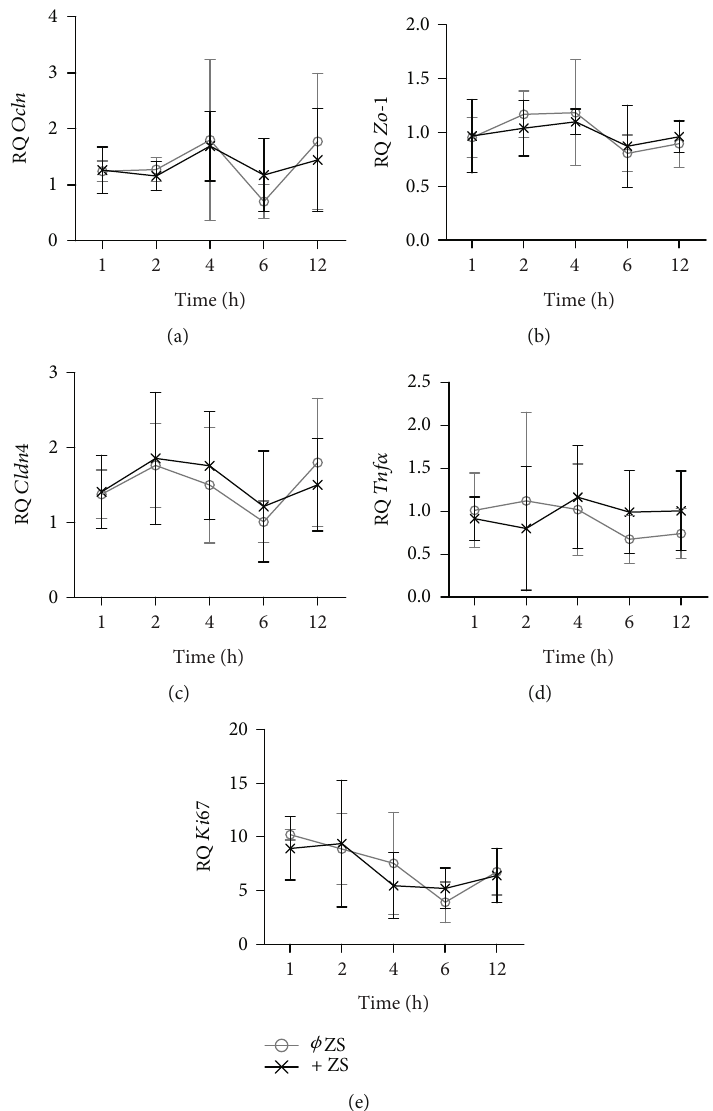
Figure 1: ZellShield® does not a ff ect organoid kinetics. Comparison of the gene expression levels in colonoids over the course of 12 hours after the administration of fresh medium with (+ ZS) and without (Ø ZS) ZellShield® (each: n = 5 ). The graphs show the means with SDs. ∗ P < 0 : 05 , ∗∗ P < 0 : 01 , ∗∗∗ P < 0 : 001 , and ∗∗∗∗ P < 0 : 0001 . (a) Relative Ocln expression, ANOVA ( F ð 9, 41 Þ = 0 : 9771 ; P = 0 : 4728 ). (b) Relative Zo-1 expression, ANOVA ( F ð 9, 42 Þ = 1 : 088 ; P = 0 : 3915 ). (c) Relative Cldn4 expression, ANOVA ( F ð 9, 42 Þ = 0 : 9054 ; P = 0 : 5295 ). (d) Relative Tnf α expression, ANOVA ( F ð 9, 42 Þ = 0 : 4397 ; P = 0 : 9055 ). (e) Relative Ki67 expression, ANOVA ( F ð 9, 41 Þ = 1 : 946 ; P = 0 : 0719